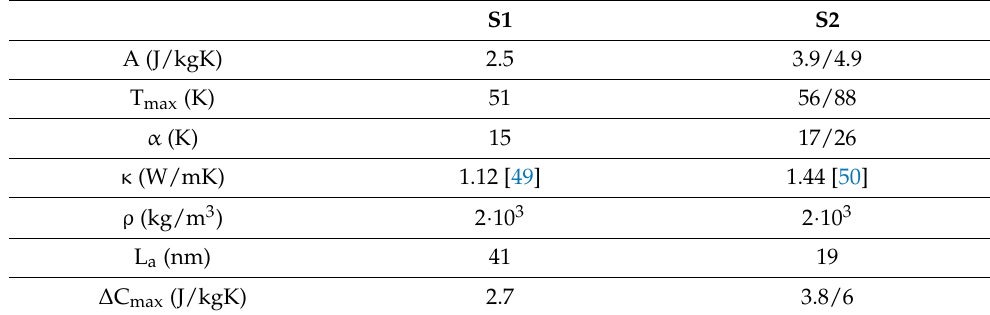
Table 3. Physical quantities governing the dependence ∆ C ( T )